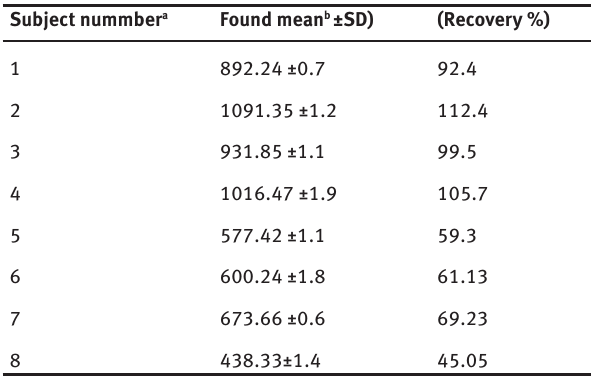
Table 6: Percentage recovery of DCV in real human plasma samples.